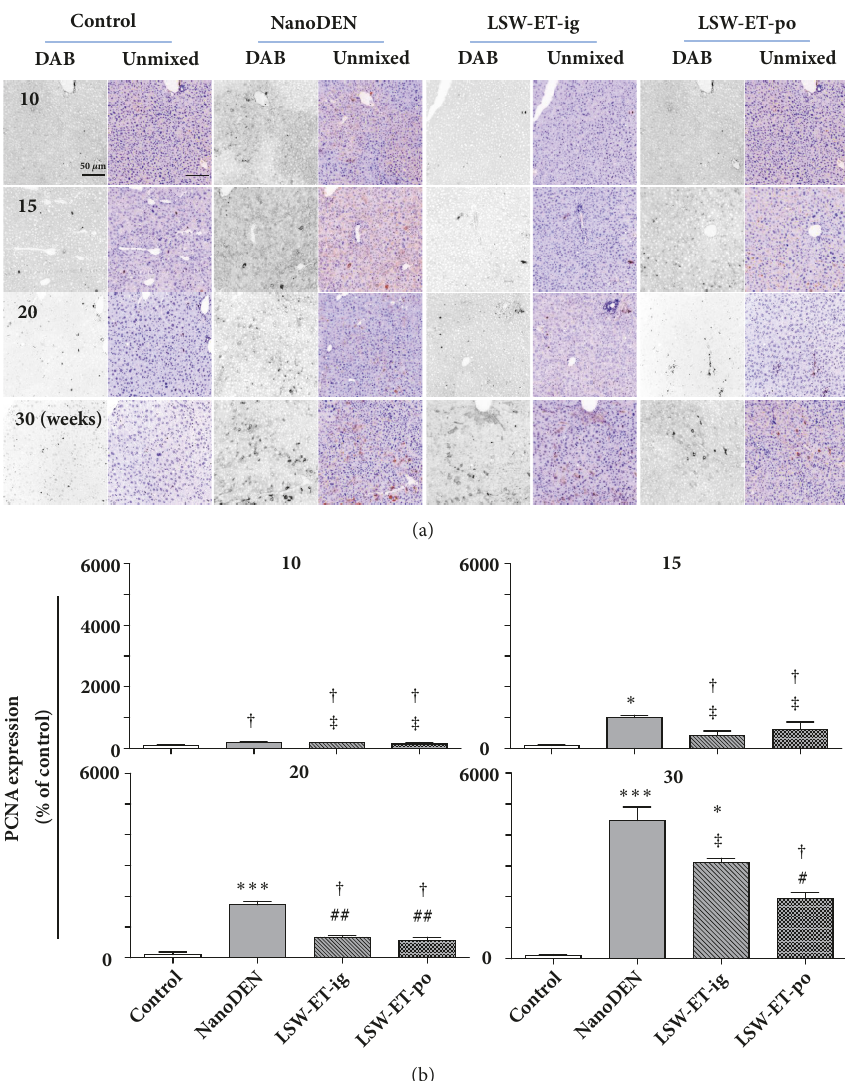
Figure 6: Oral application of L S W-ET decreased the nano D EN-induced PCNA expression in mice. (a) Expression of PCNA by immunohistochemistry. Scale bar, 50 휇 m. (b) Quantitative expression of PCNA determined by immunohistochemistry.